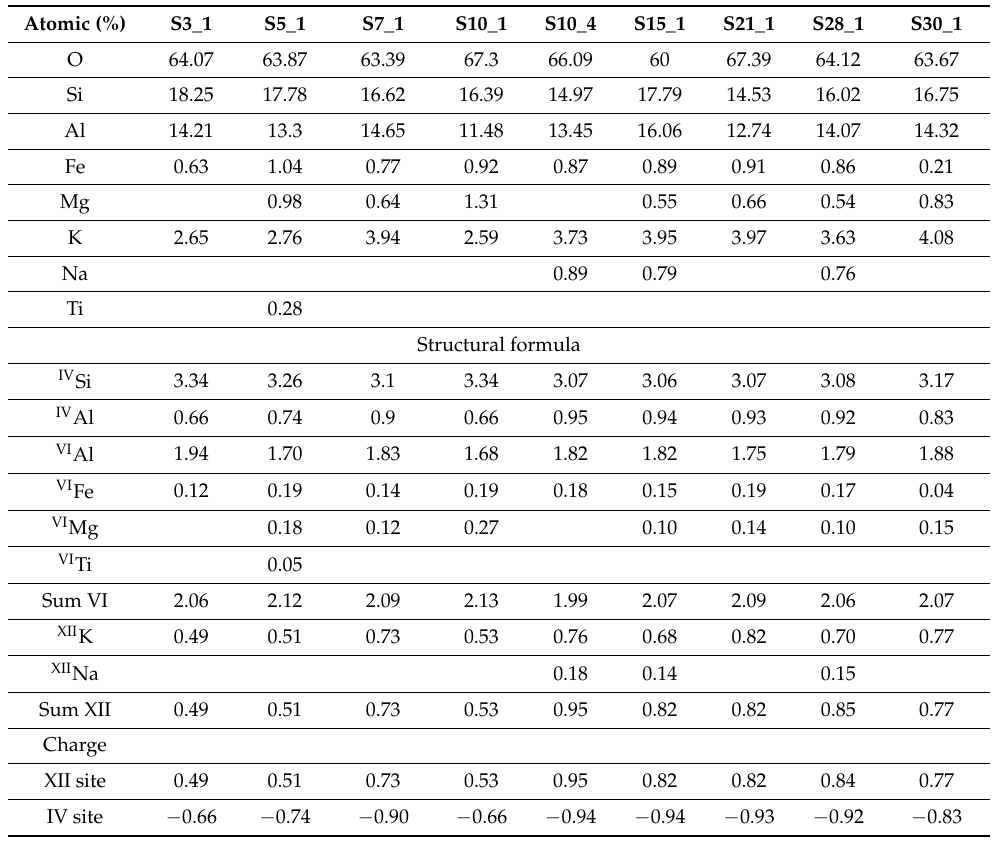
Table 3. The EDS chemical composition of dioctahedral 2:1